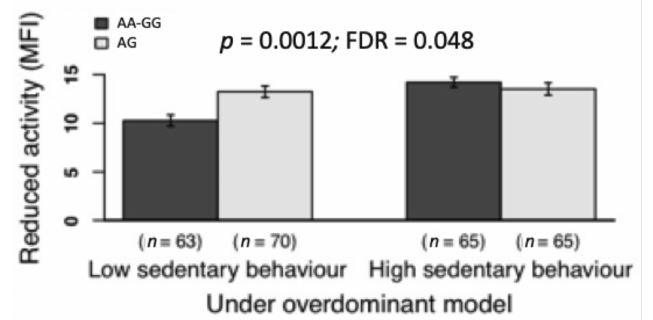
Figure 4. Associations of the interaction of the SCN9A gene (rs7607967 polymorphisms)-sedentary behavior with reduced activity (a dimension of fatigue). Note. SCN9A , sodium voltage-gated